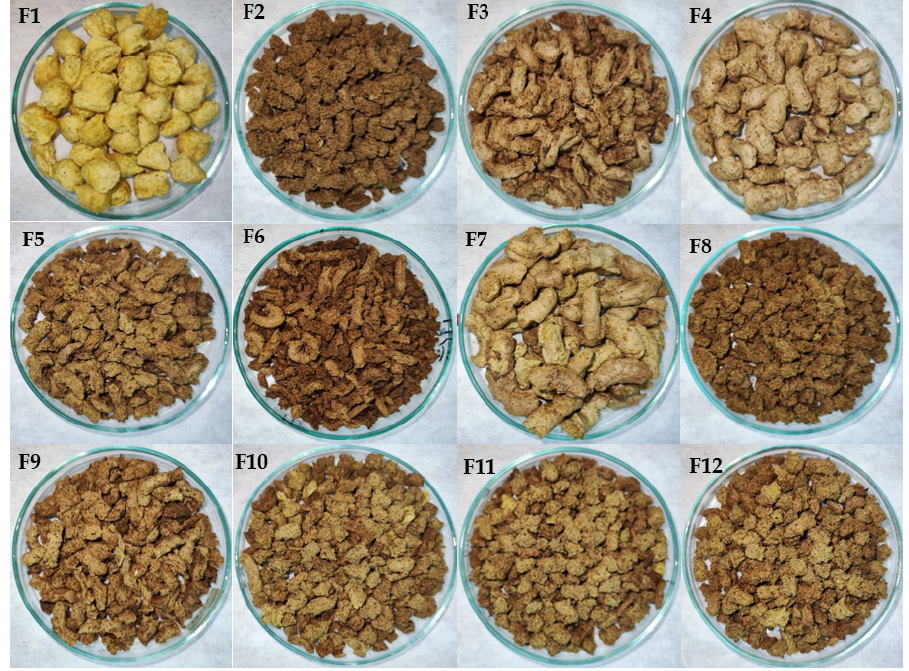
Figure 3. Images of extrudates made of CG ( F1 ), SQF ( F2 ), SCF ( F3 ), binary ( F4 – F6 ) and ternary ( F6 – F12 ) flour blends of the same. Abbreviations: CG, corn grit; SCF, sprouted cañihua flour; SQF, sprouted quinoa flour.